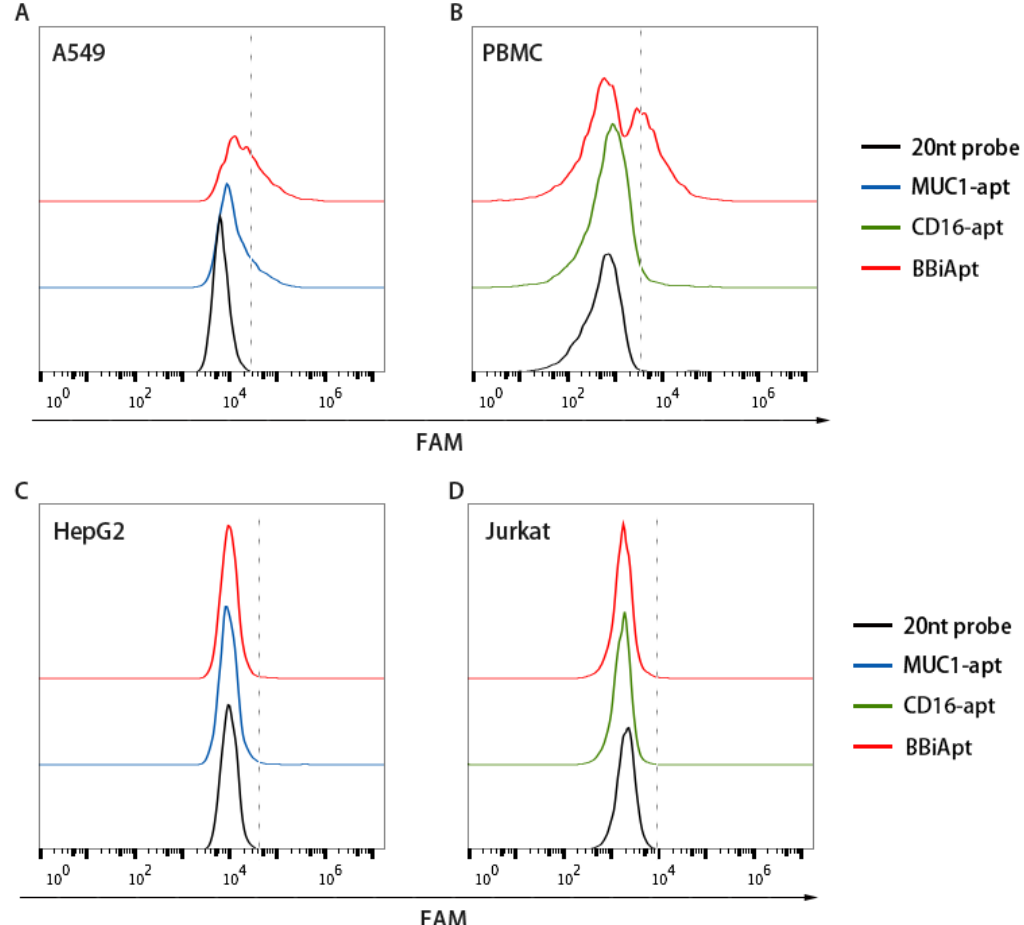
Figure 3. Bindings of BBiApt and monovalent MUC1 or CD16 aptamers to target or control cells. A FAM-labeled 20 nt probe that hybridized to the nonfunctional part of BBiApt was utilized to generate fluorescent signal for BBiApt. This 20 nt probe also served as the background control. MUC1-positive A549 cells ( A ), CD16-positive PBMCs ( B ), MUC1-negative HepG2 cells ( C ), or CD16-negative Jurkat cells ( D ) were treated with the probe (black lines), monovalent aptamers (blue and green lines), or BBiApt (red lines), and evaluated by flow cytometry.